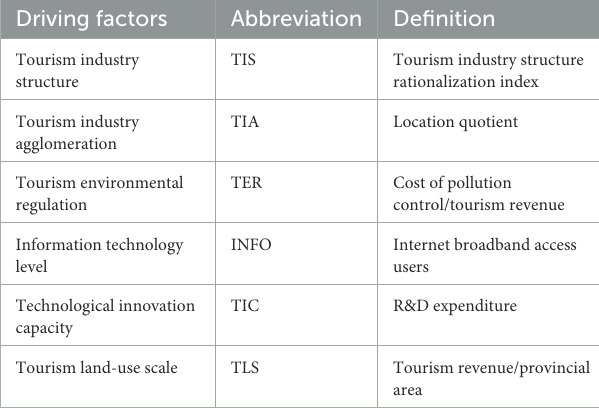
TABLE 2 Variables and explanations of tourism ecosystem health influencing